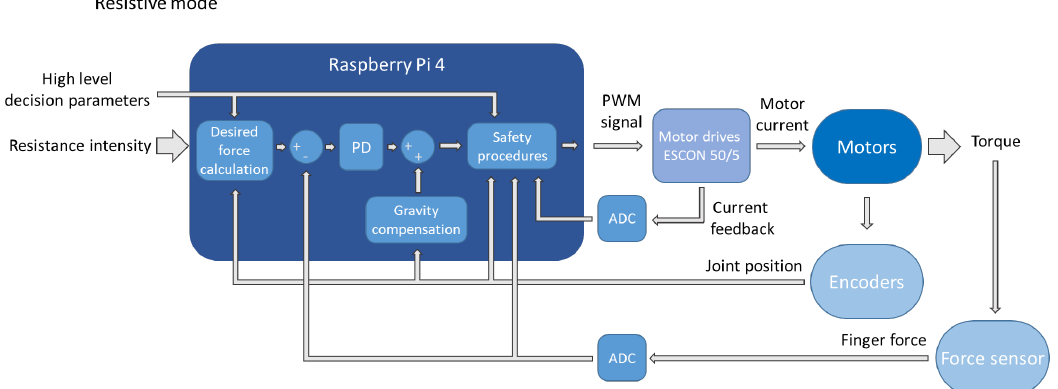
Figure 6. A block diagram for the resistive mode of operation with all the used hardware and signals.